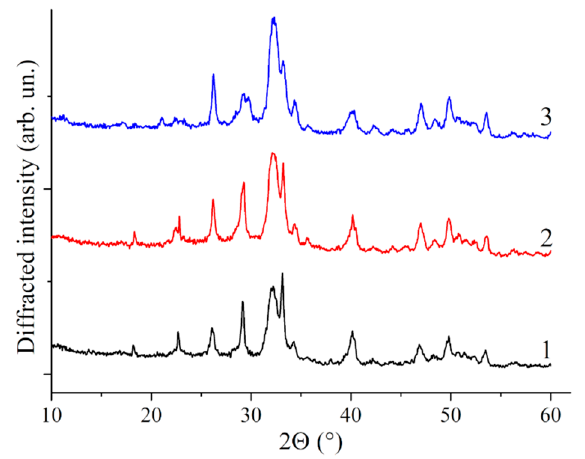
Figure 2. X-ray diffraction patterns obtained after the annealing of the composites at 900 °C. 1— sample; 2—sample 2; 3—sample 3. All peaks correspond to HA (card #9-432) (samples 1–3, Table 1).